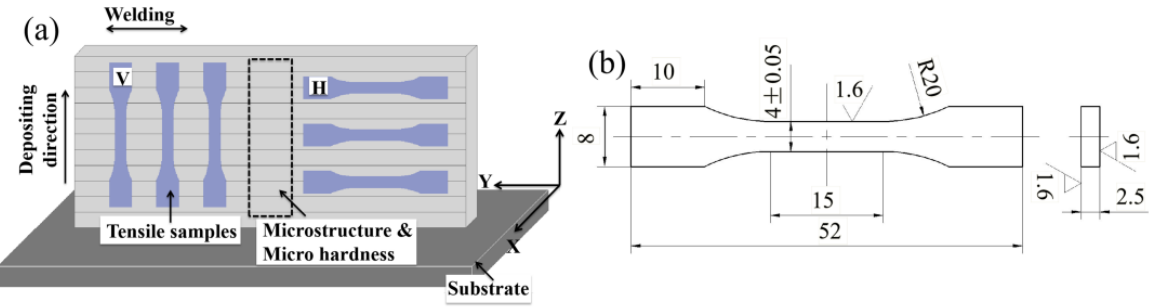
Figure 1. Schematics of ( a ) the sampling positions and ( b ) the dimensions of tensile samples.